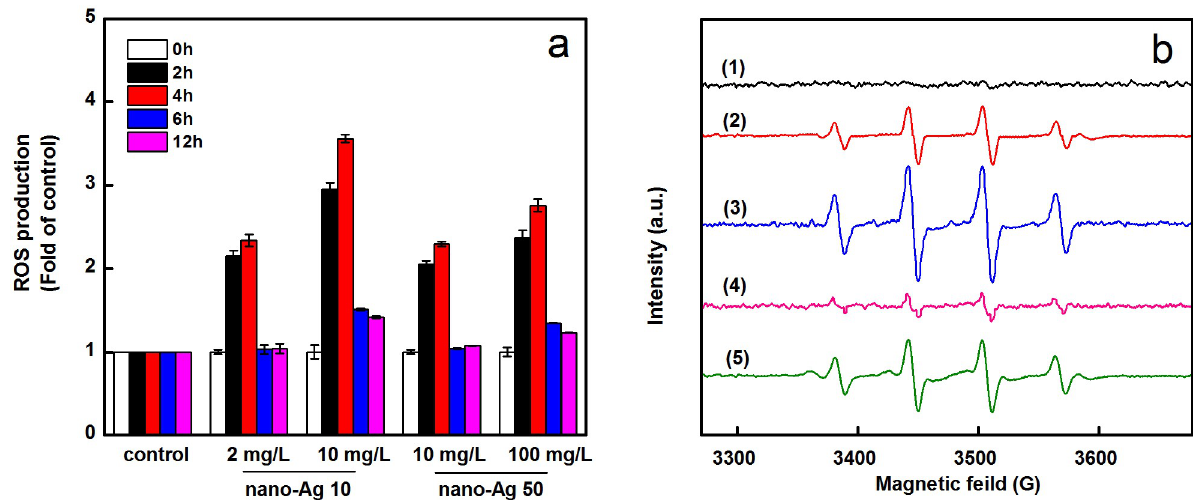
Fig 6. Changes in intracellular ROS levels of A . vinelandii (a) and generation of hydroxyl radicals by two sizes of AgNPs (b). Electron spin resonance (ESR) spectra were obtained from samples containing 50 mM DMPO + 0.5 mM H 2 O 2 + 10 mM pH 3.6 HAc-NaAc in the presence of control (1), 2 mg/L (2), 10 mg/L (3) of nano-Ag 10, and 10 mg/L (4), 100 mg/L (5) of nano-Ag 50, respectively.